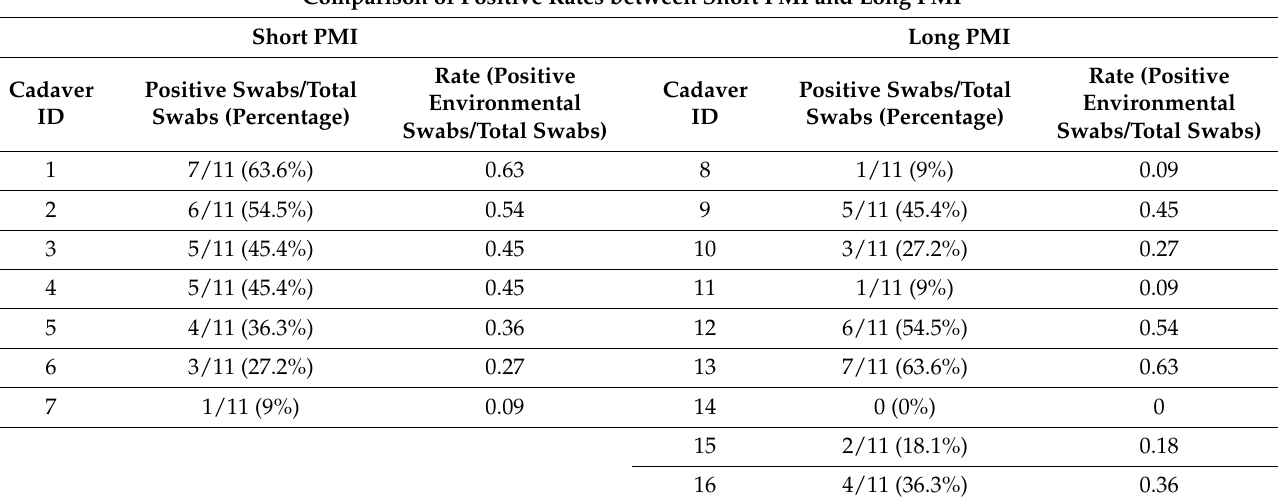
Table 2. All environmental swabs collected at T1 were split into two groups: “Short PMI” and “Long PMI”. The statistical analysis was performed obtaining the positive rate (ratio among positive environmental swabs and total sampled swabs). Comparison of Positive Rates between Short PMI and Long